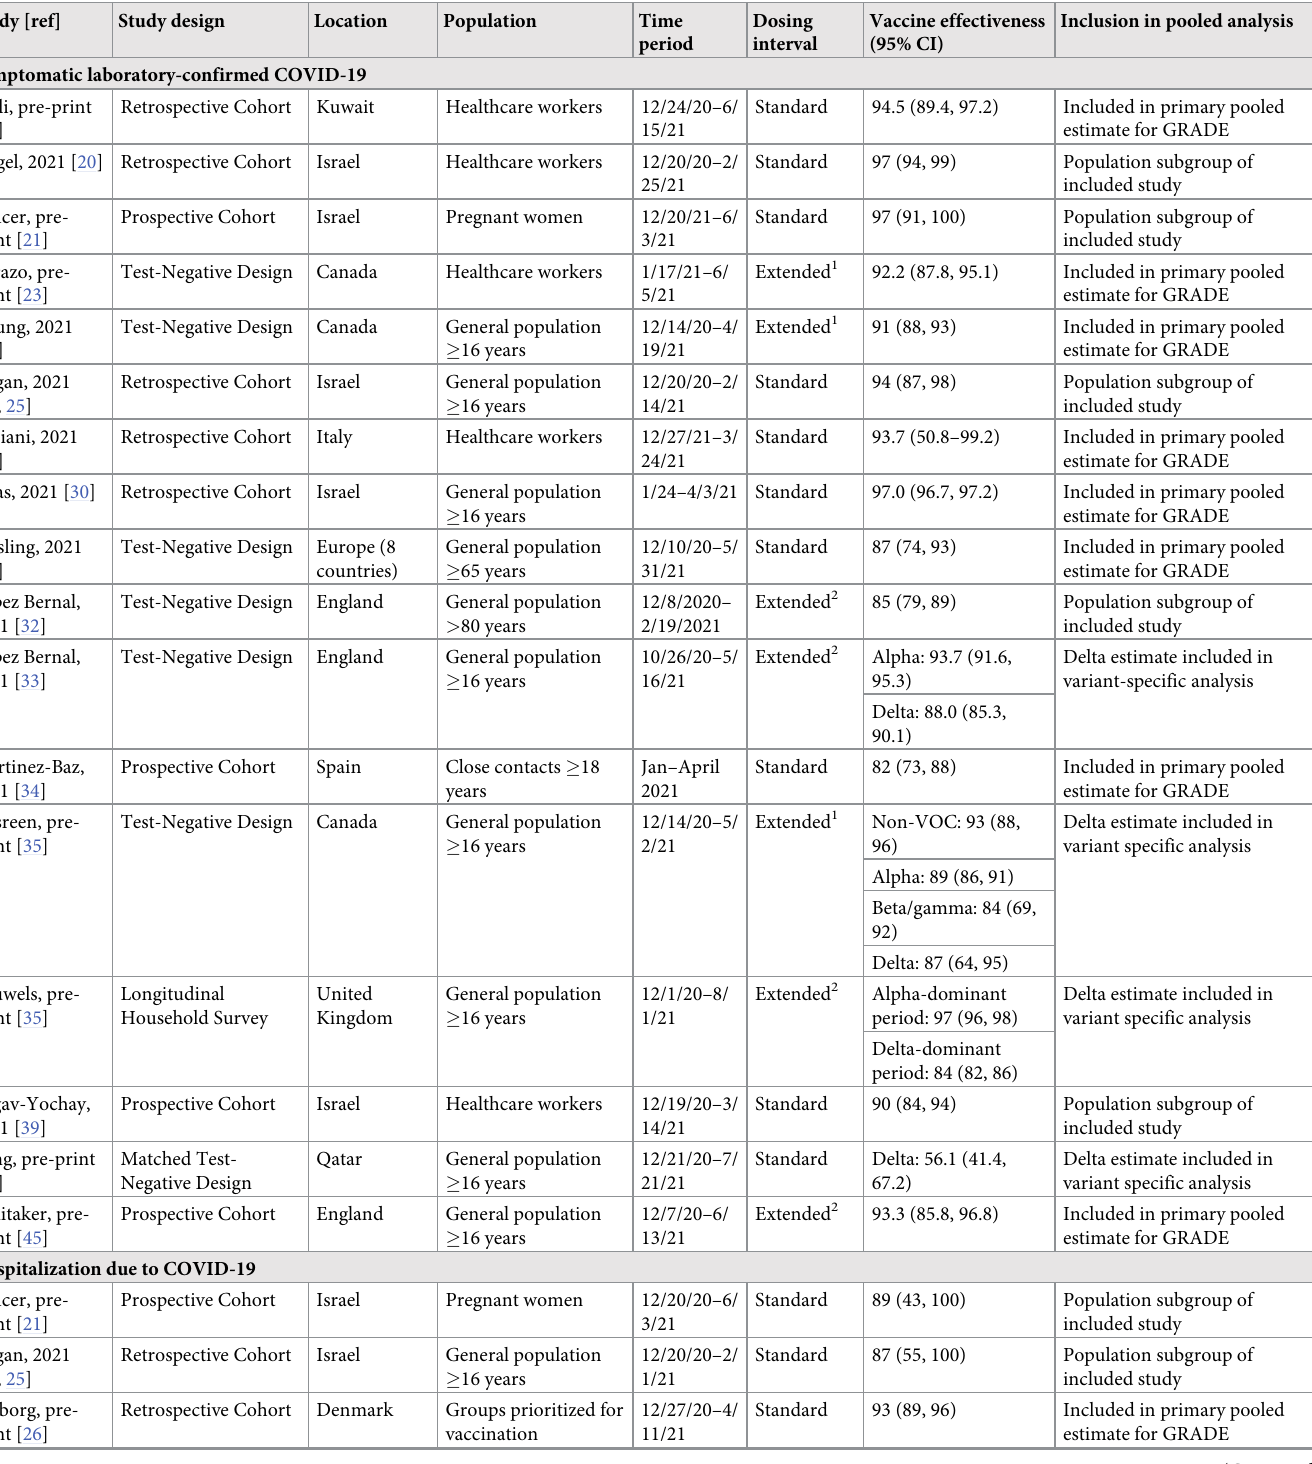
Table 2. Characteristics of studies eligible for inclusion in pooled analysis of vaccine effectiveness of Pfizer-BioNTech COVID-19 vaccine, by beneficial outcome of